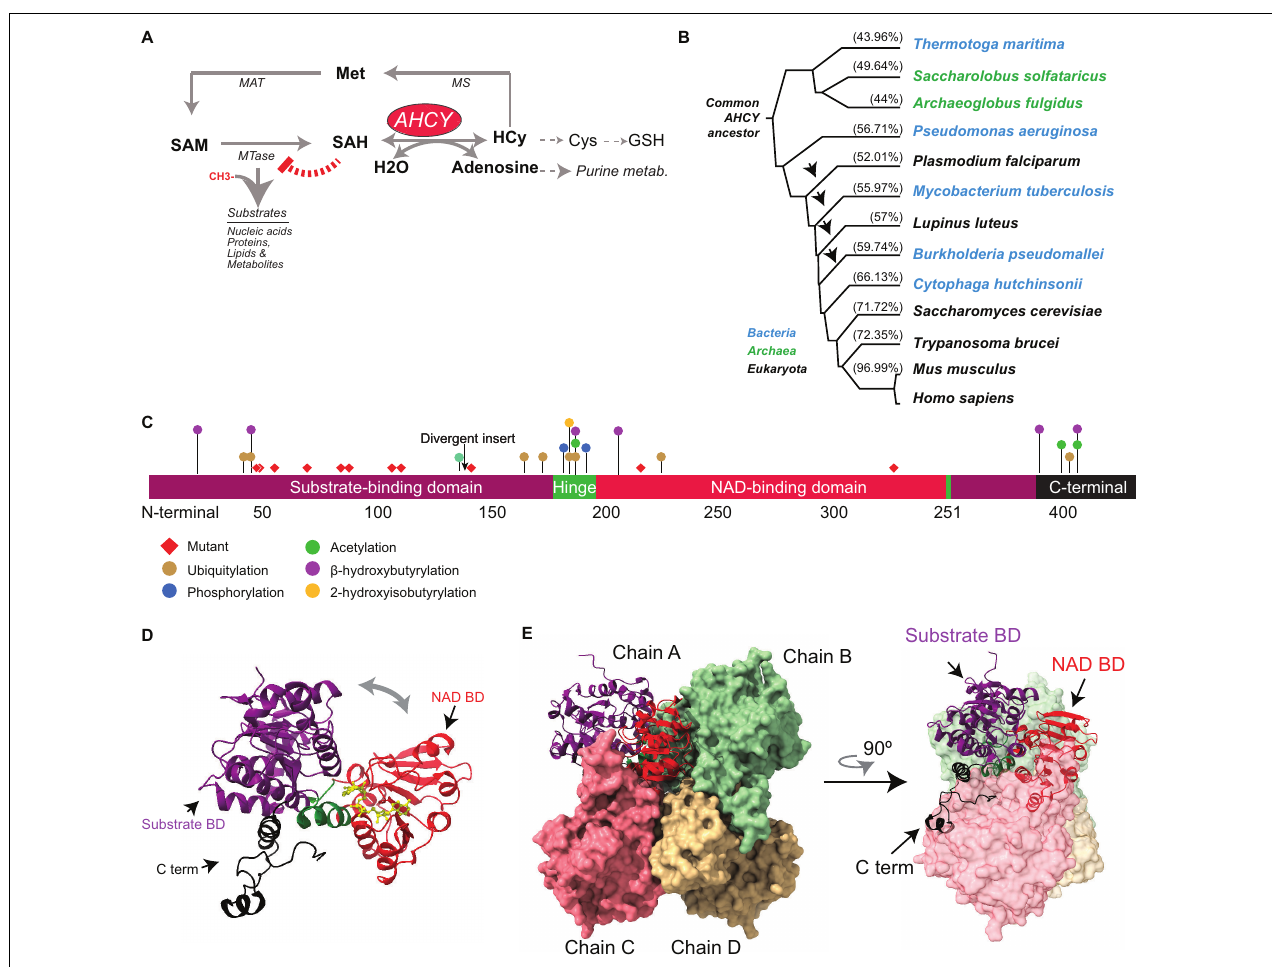
FIGURE 1 | Evolution and structure of adenosylhomocysteinase (AHCY). (A) Scheme of the methionine (Met) metabolic pathway. Enzymes of the pathway are indicated AHCY, methionine adenosyltransferase (MAT), methionine synthase (MS), and SAM-dependent methyltransferase (MTase). MTase transfer a methyl group from SAM to substrates, thereby generating SAH. AHCY breaks SAH into adenosine and homocysteine (Hcy). Hcy can be recycled to methionine (Met) coupled to folate metabolism or to produce glutathione. (B) Selected AHCY amino acid sequences were obtained from Uniprot (https://www.uniprot.org/) using the